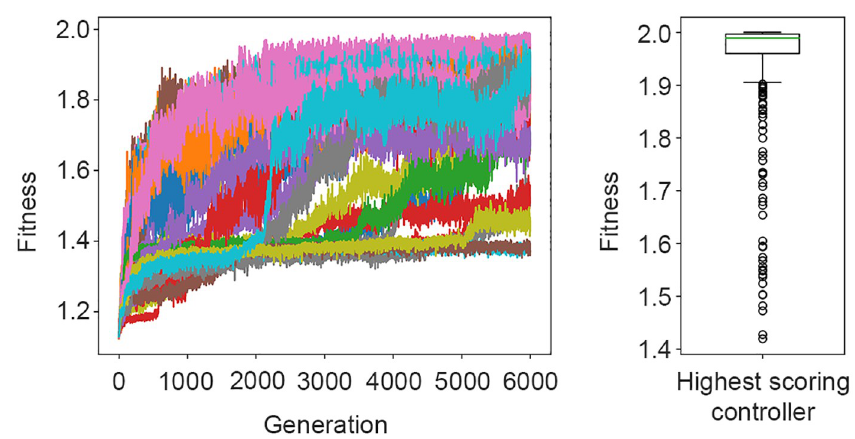
Fig 8. Left: Fitness trajectories of the 30 controllers within 6000 generations. Right: Box-plot of the results of the 400 post-evaluation samples achieved by the highest-scoring controller of the No Alignment setup .